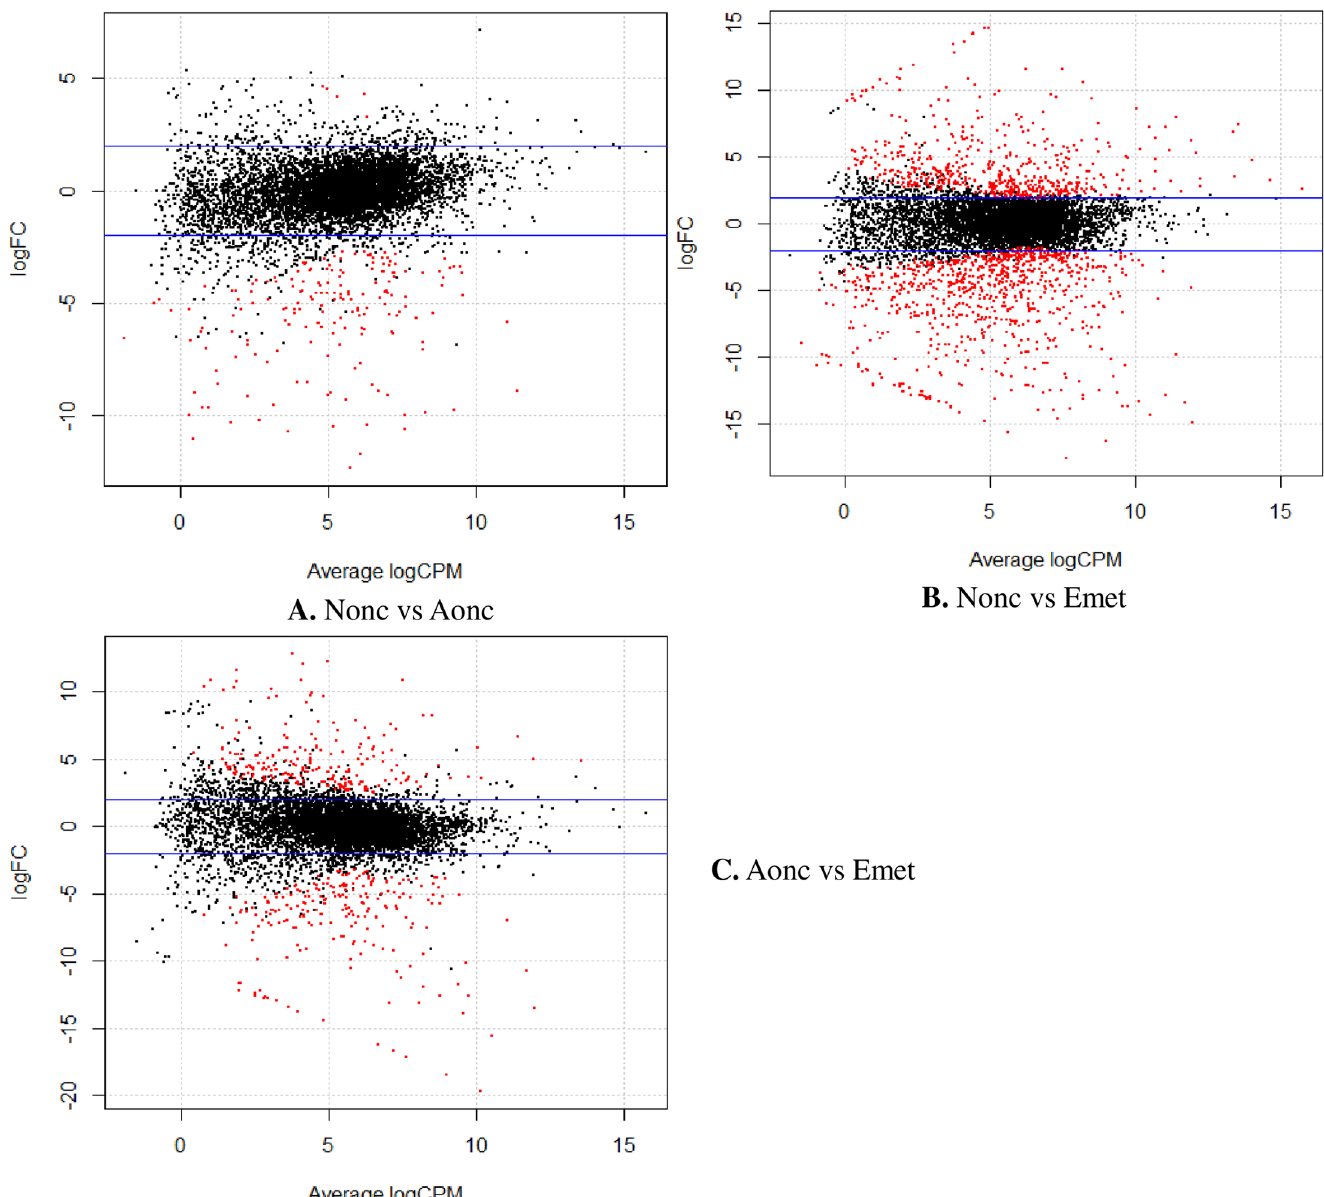
Fig 4. Analyses of differentially expressed genes (DEGs) among non-activated oncophere (Nonc), activated oncosphere (Aonc) and early stage of metacestode (Emet).